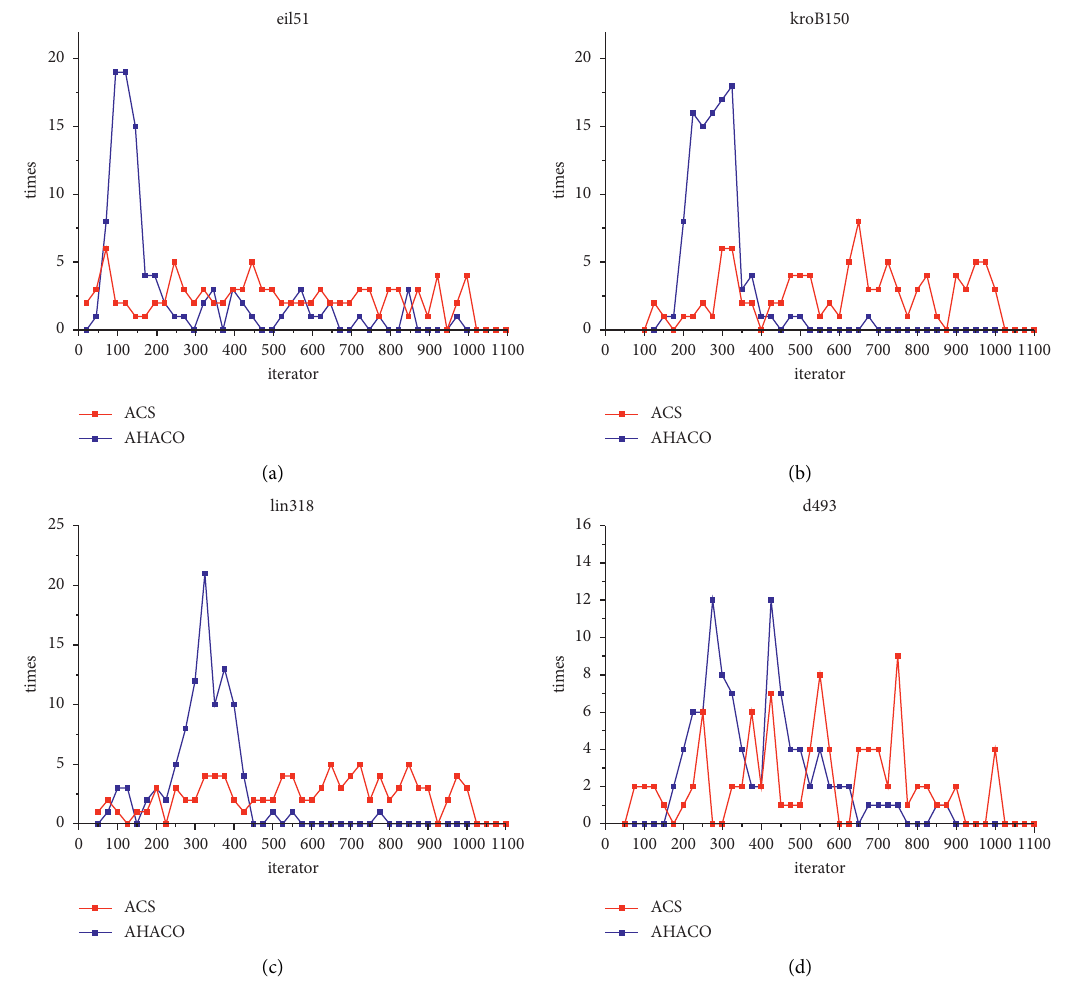
Figure 7: Optimal solution statistical distribution. (a) eil51. (b) kroB150. (c) lin318. (d)